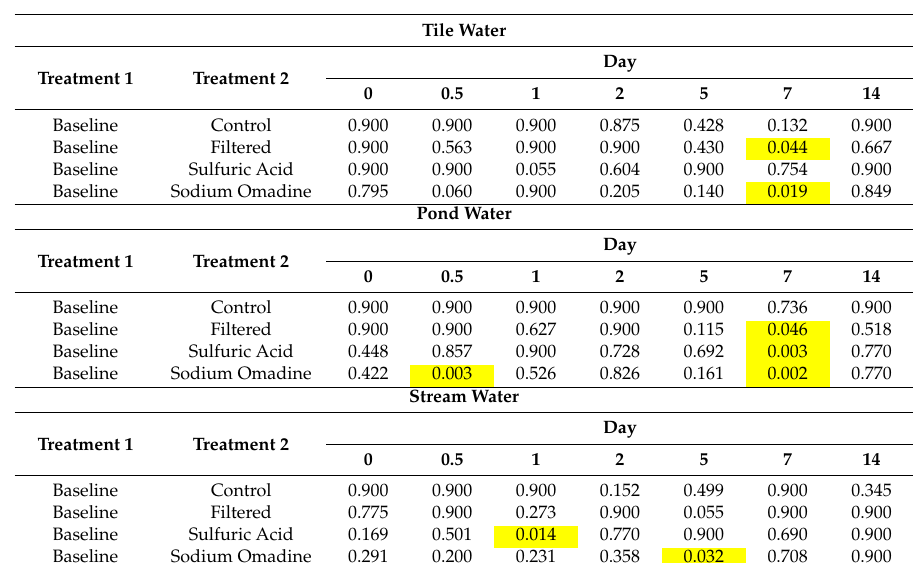
Table 4. Significant differences between methods for nitrate-N measurement were calculated using Tukey honestly significant difference (HSD) method and the p -values are presented for each treatment comparison and day. Significant differences ( p < 0.05) are highlighted in yellow for